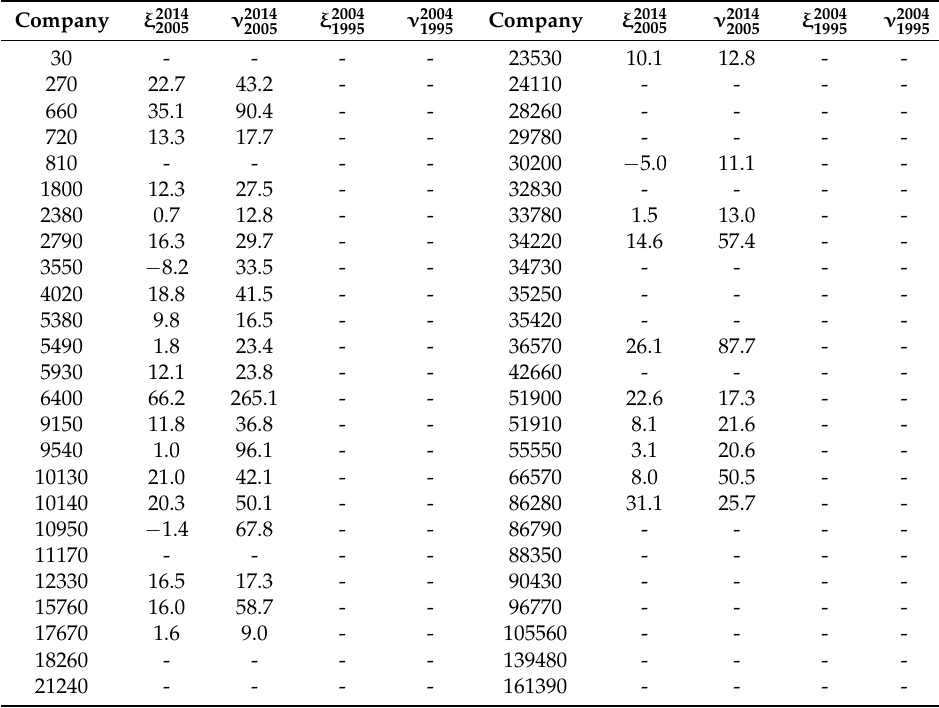
Table A10. Estimated parameters ξ ( % ) and ν ( % ) , for each company of KOSPI50 index. Company